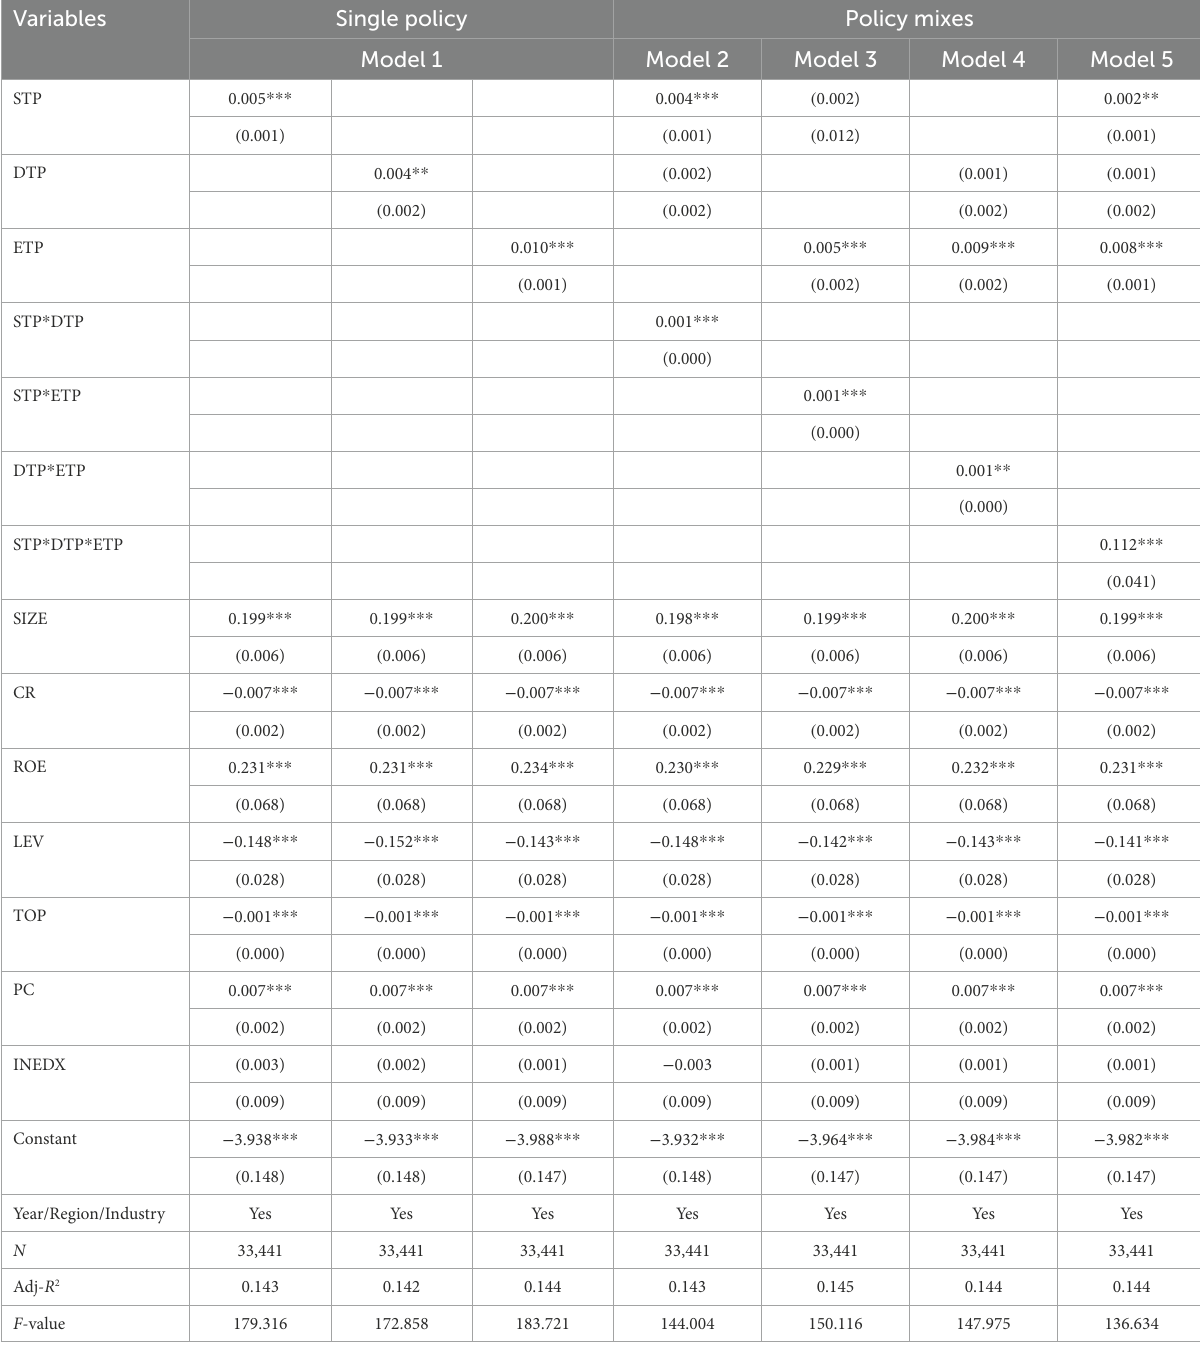
TABLE 5 Results of the multidimensional fixed-effect OLS model.